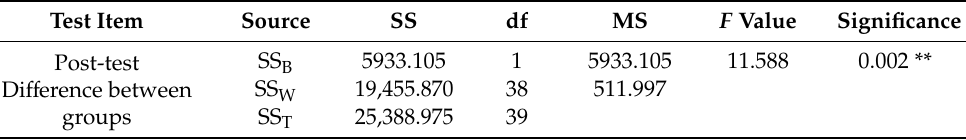
Table 4. One-way ANOVA summary table for two groups of learning